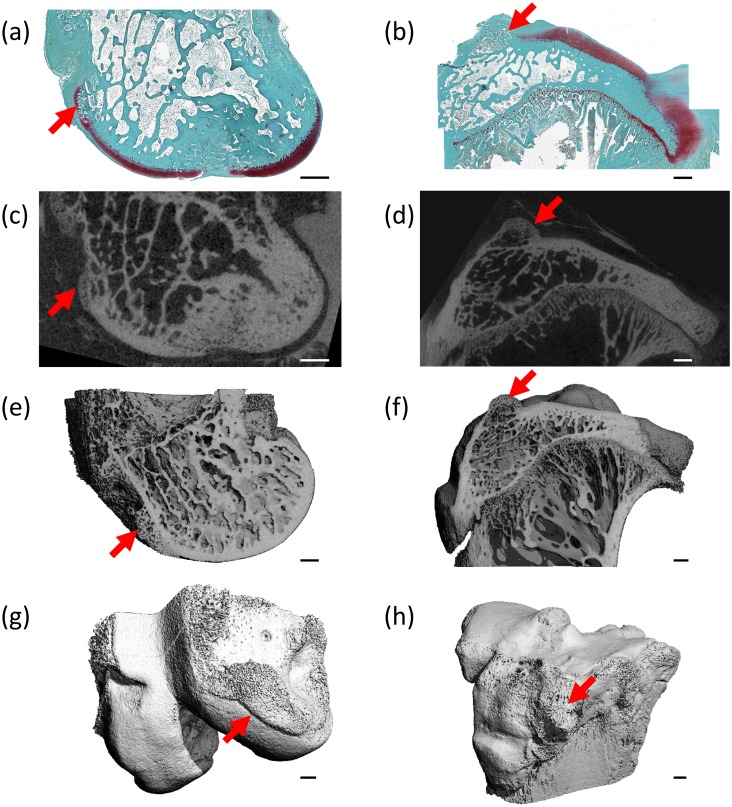
Visualisation of osteophytes.Osteophytes (red arrows) are indicated in the femur (a,c,e,g) and tibia (b,d,f,h) as visualised with (a-b) histology, (c-h) microCT: (c-d) the matching microCT image, (e-f) a cut-through the microCT 3D greyscale image showing low attenuating osteophyte masses, and (g-h) a 3D reconstruction of the microCT scan (PRE).